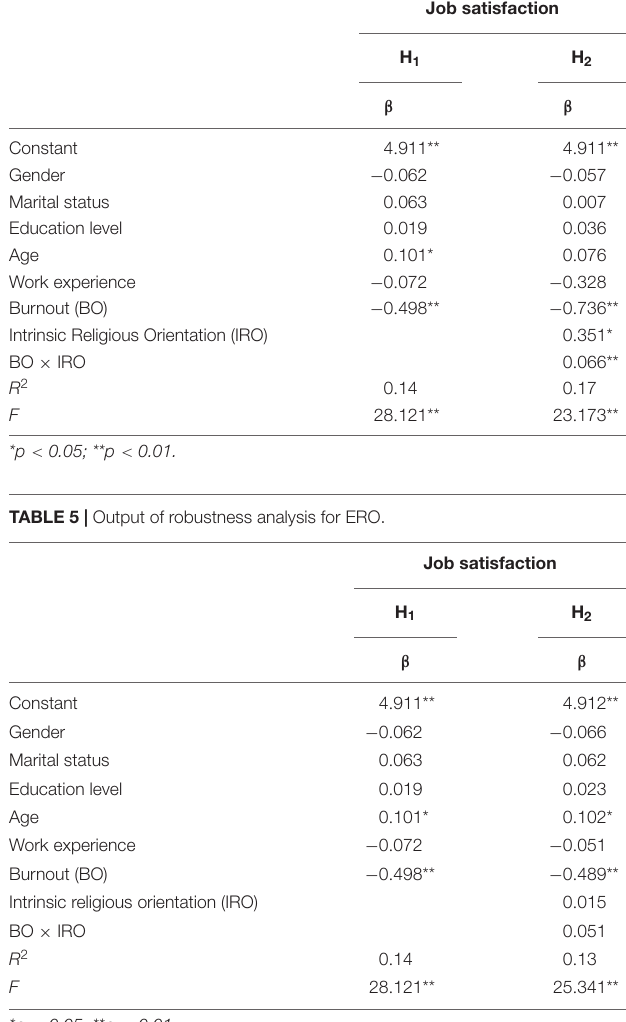
FIGURE 1 | The interaction between burnout and intrinsic religious orientation (IRO). TABLE 3 | Extrinsic religious orientation (ERO) moderating analysis.